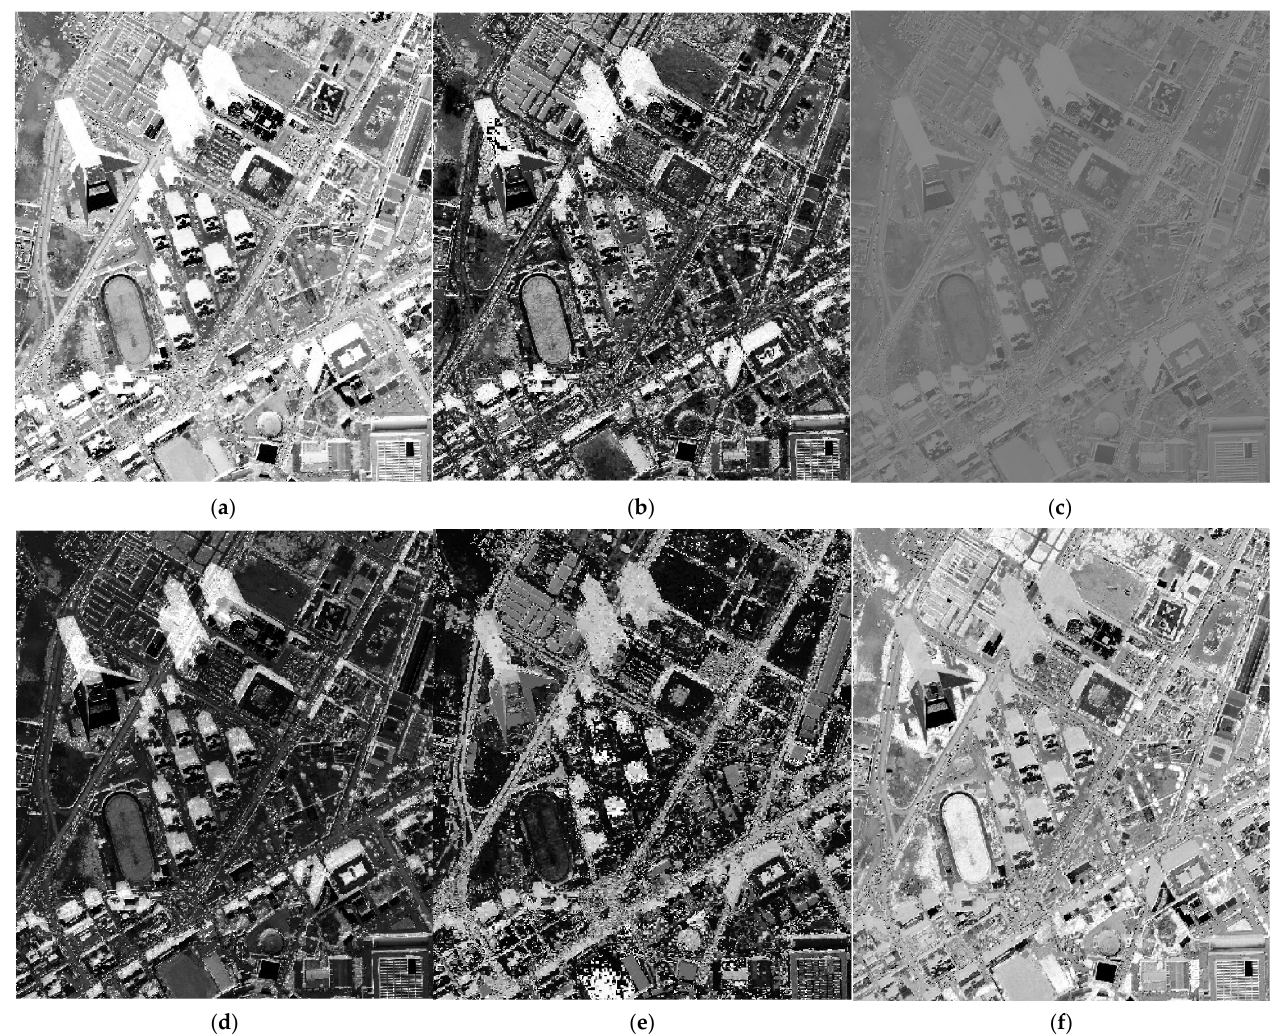
Figure 11. Comparisons of the indexes in Site 1: ( a ) ISI; ( b ) NSVDI; ( c ) CSI; ( d ) T YCbCr ; ( e ) T HSV ; and ( f )